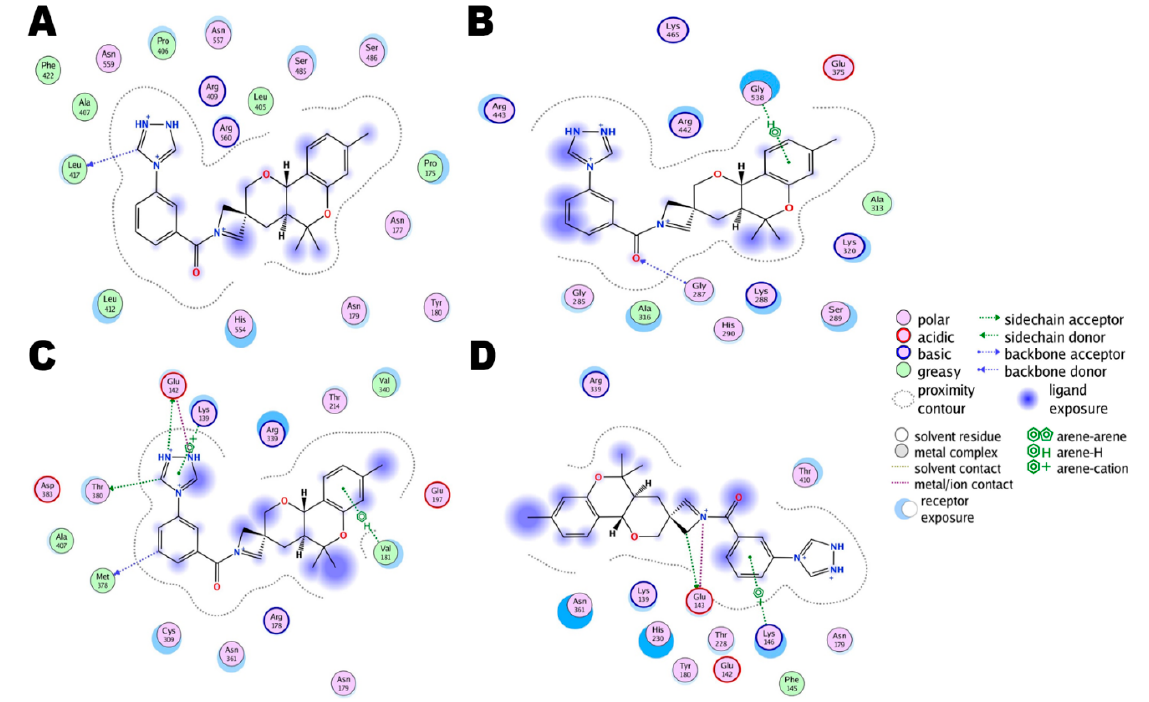
Figure 5. Binding interactions of the top ranked compound docked at different binding sites of the SARS-CoV-2 helicase enzyme. ( A ). Site 1, ( B ). Site 2, ( C ) . Site 3, and ( D ). Site 4.